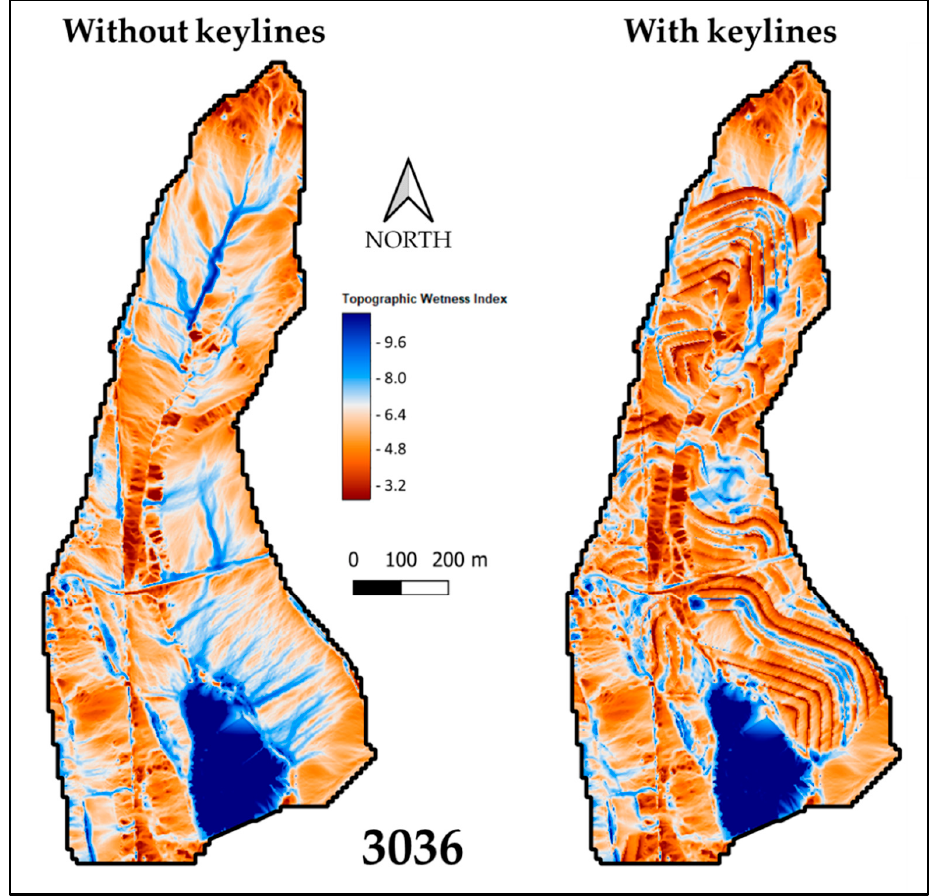
Figure 4. Topographic Wetness Index (TWI) maps with and without the keylines for basin 3036.